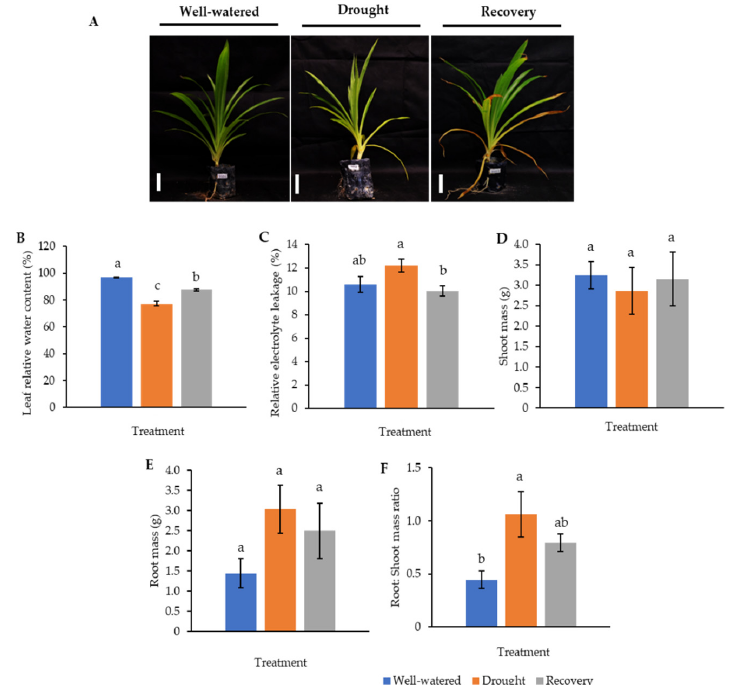
Figure 3. Comparison of well-watered, drought-stressed, and water-recovered Pandanus amaryllifolius plants. ( A ) Pandanus plants were subjected to drought stress by withholding water for 7 days, whereas the water-recovered plants were rewatered after a 7-day drought treatment and rewatered for 7 days. Well-watered P. amaryllifolius served as control. The line bar indicates the scale of the plant = 10 cm. ( B ) The percentage of leaf relative water content of P. amaryllifolius leaves. ( C ) The percentage of relative electrolyte leakage for each sample. ( D ) Shoot mass of P. amaryllifolius . ( E ) Root mass of P. amaryllifolius . ( F ) Root-to-shoot mass ratio of P. amaryllifolius . Means labeled with alphabet were significantly different based on the ANOVA followed by post hoc when its p -value <